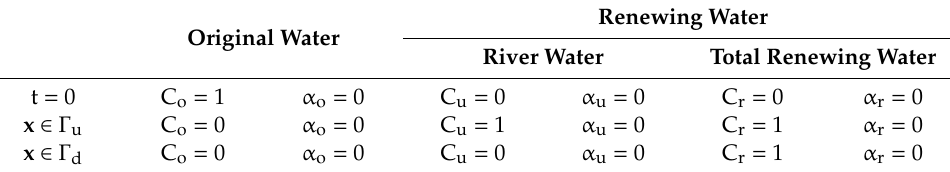
Table 1. Boundary and initial conditions for calculating the age in the domain of interest. Renewing Water Original Water River